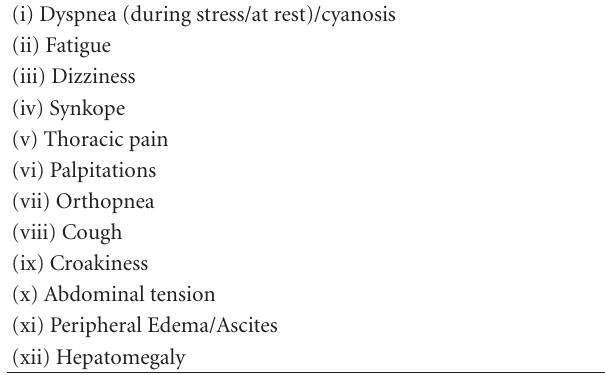
Table 3: Clinical findings in patients with pulmonary hypertension (mod.